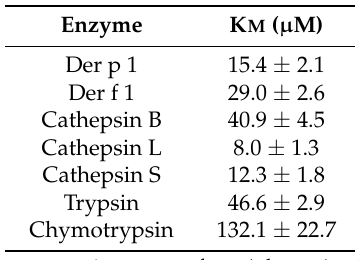
Table 1. Measured K M values for ADZ 50,059 against Der p 1 and a panel of cysteine and serine peptidases.